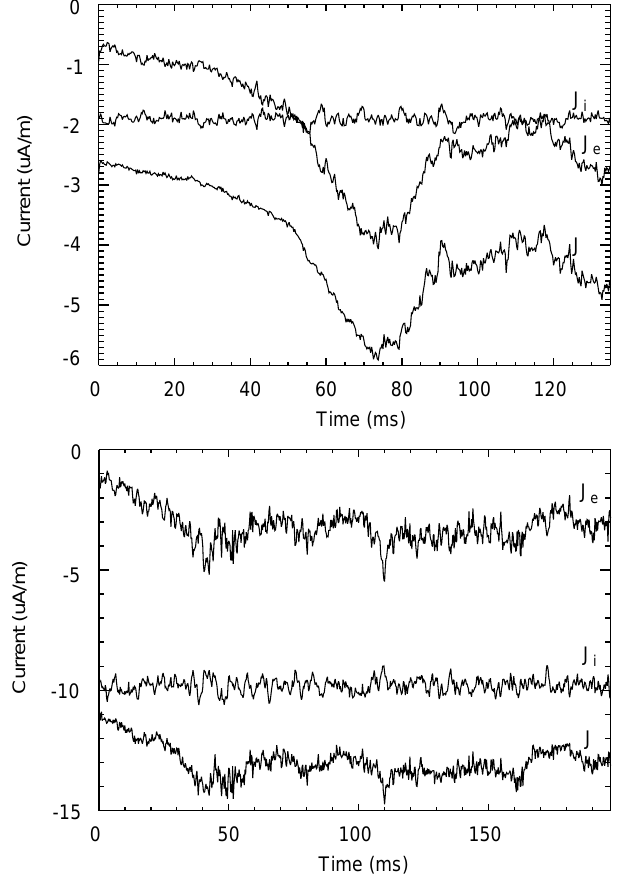
Fig. 3. Vertical currents versus time from two Farley-Buneman instability simulations with the parameters shown in Table 1. The upper figure derives from simulation 1 while the lower from simulation 2. Both show the ion current, J i , the electron current, J e , and the total vertical current, J : J i shows the ion-Pederson current, largely unmodified by the wave growth. J e starts with a small electron- Pedersen current and develops a wave-driven current as the